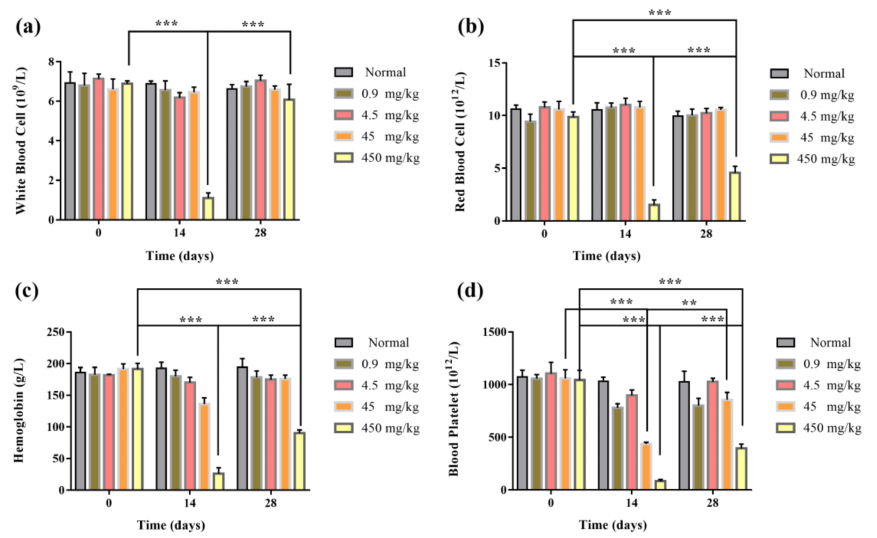
Figure 9. The blood routine indexes of mice injected via tail vein with 200 µ L of Fe 2 O 3 /Fe 3 O 4 heterogeneous nanoparticles solutions of various concentrations: ( a ) white blood cell (WBC), ( b ) red blood cell (RBC), ( c ) hemoglobin (HB), and ( d ) blood platelet (blood) (the control groups were injected with the same volumes of normal saline). ** p ≤ 0.01, *** p ≤ 0.001 versus control group, n =